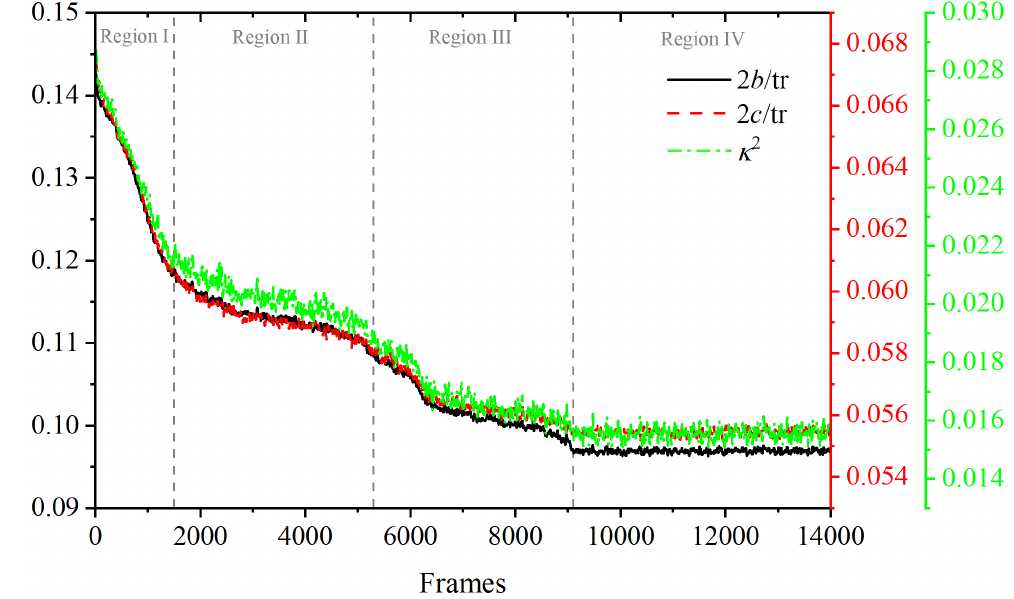
Figure A3. Shape descriptors asphericity b , acylindricity c , and relative shape anisotropy κ 2 . The first two are made dimensionless by dividing by half the trace of G